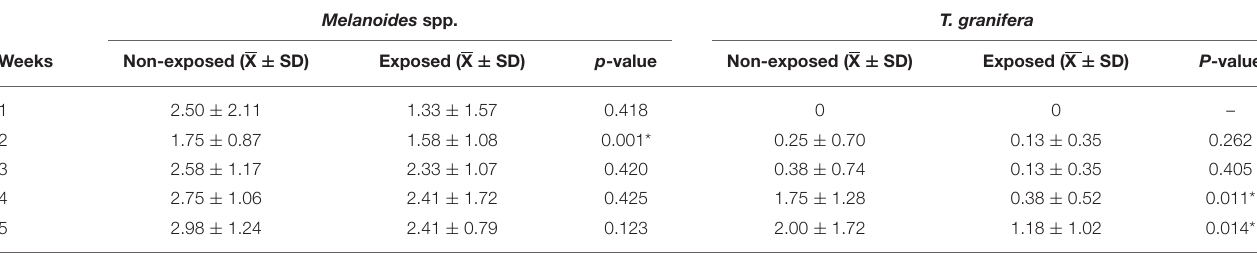
TABLE 2 | Weekly average production of offspring by exposed to Calicophoron microbothrium miracidia and non-exposed groups of Melanoides sp. and Tarebia granifera . Melanoides